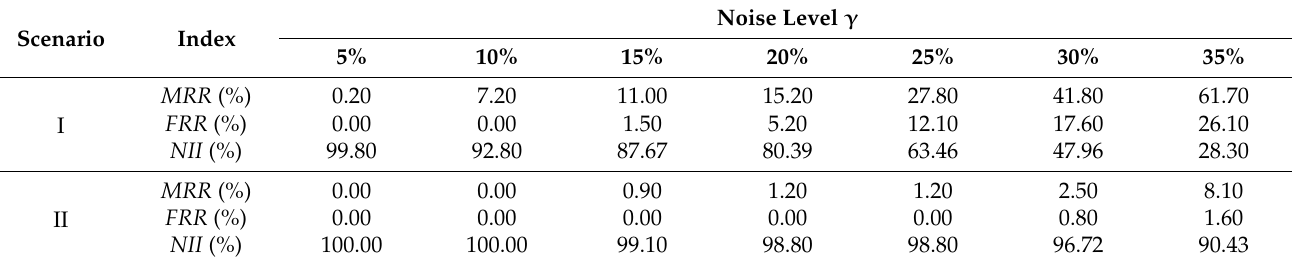
Table 2. Results of the noise-resistance analysis based on CWT-SSSM feature method in different noise conditions.